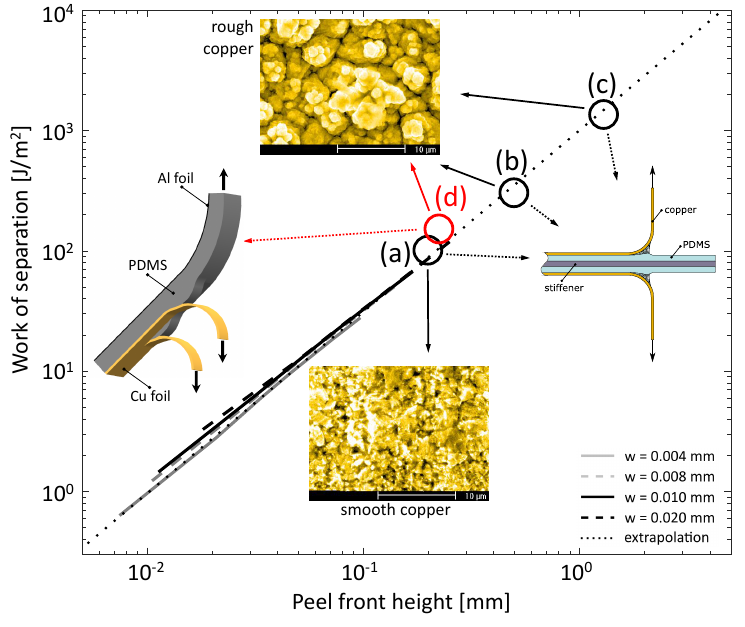
Figure 8. Work-of-separation versus the peel front height including the result of the new experiment indicated by the red circle. Earlier reported experimentally measured values from the 90 ◦ peel test are included in the figure as black circles: ( a ) smooth copper, h PDMS = 0.75 mm [28]; ( b ) rough copper, h PDMS = 0.75 mm [28]; ( c ) rough copper, h PDMS = 1.0 mm [25,26]; ( d ) alternative 180 ◦ peel test